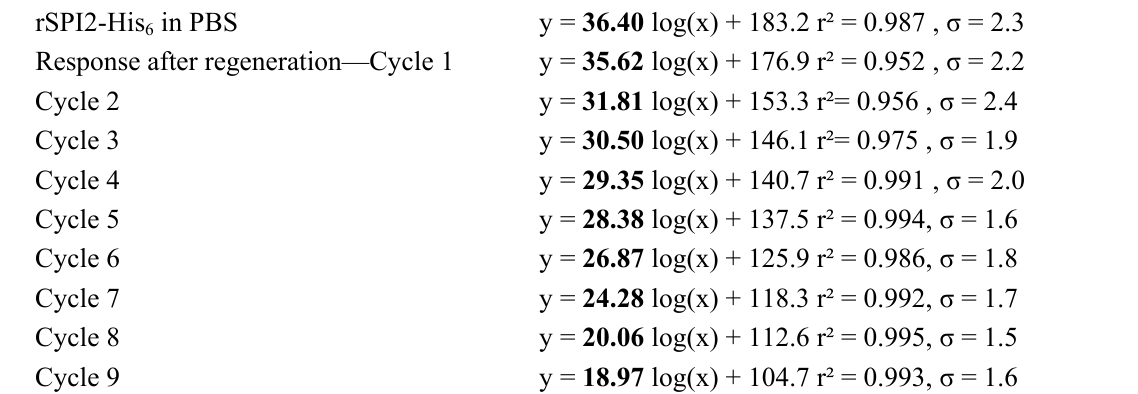
Table 4 . Regeneration of the immunosensor incorporating Anti-His IgG F(ab’) fragment regenerated with 0.1 M Gly-HCl pH 2.8 buffer. Response measured by SPR towards in PBS buffer pH rSPI2-His 6